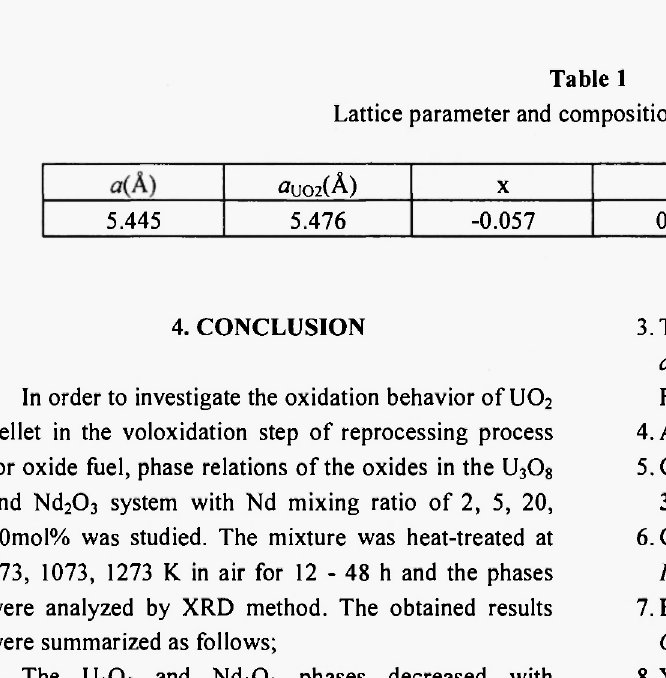
Lattice parameter and composition of Nd y Ui. y 02+ x